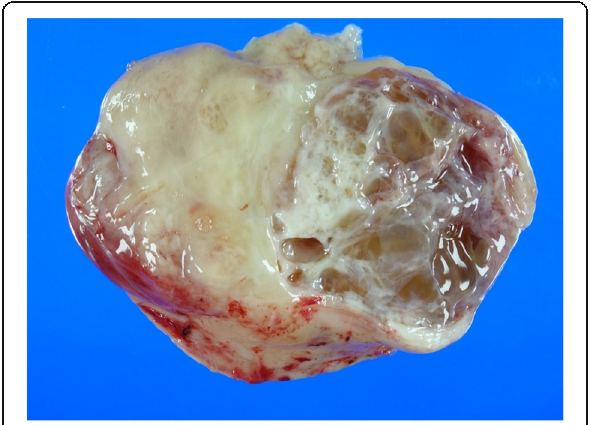
Fig. 3 Macroscopic analysis of the malignant solitary fibrous tumor. The tumor displayed a firm, ivory-like appearance and partly cystic and myxoid resected